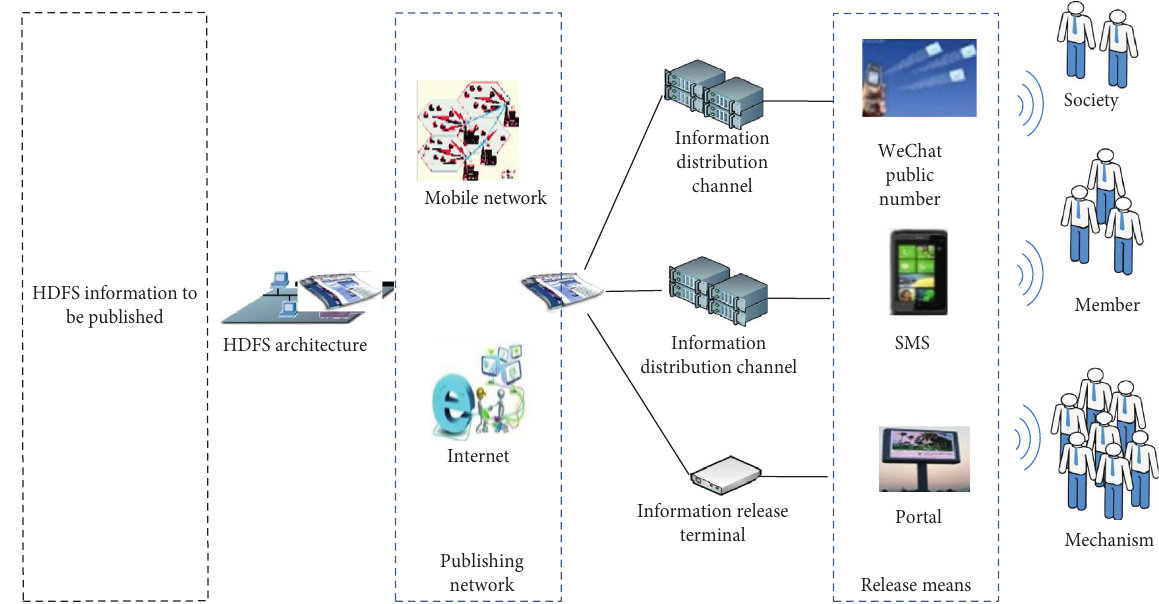
Figure 1: HDFS and DFS structure diagram. Table 1: Noise sentence pair